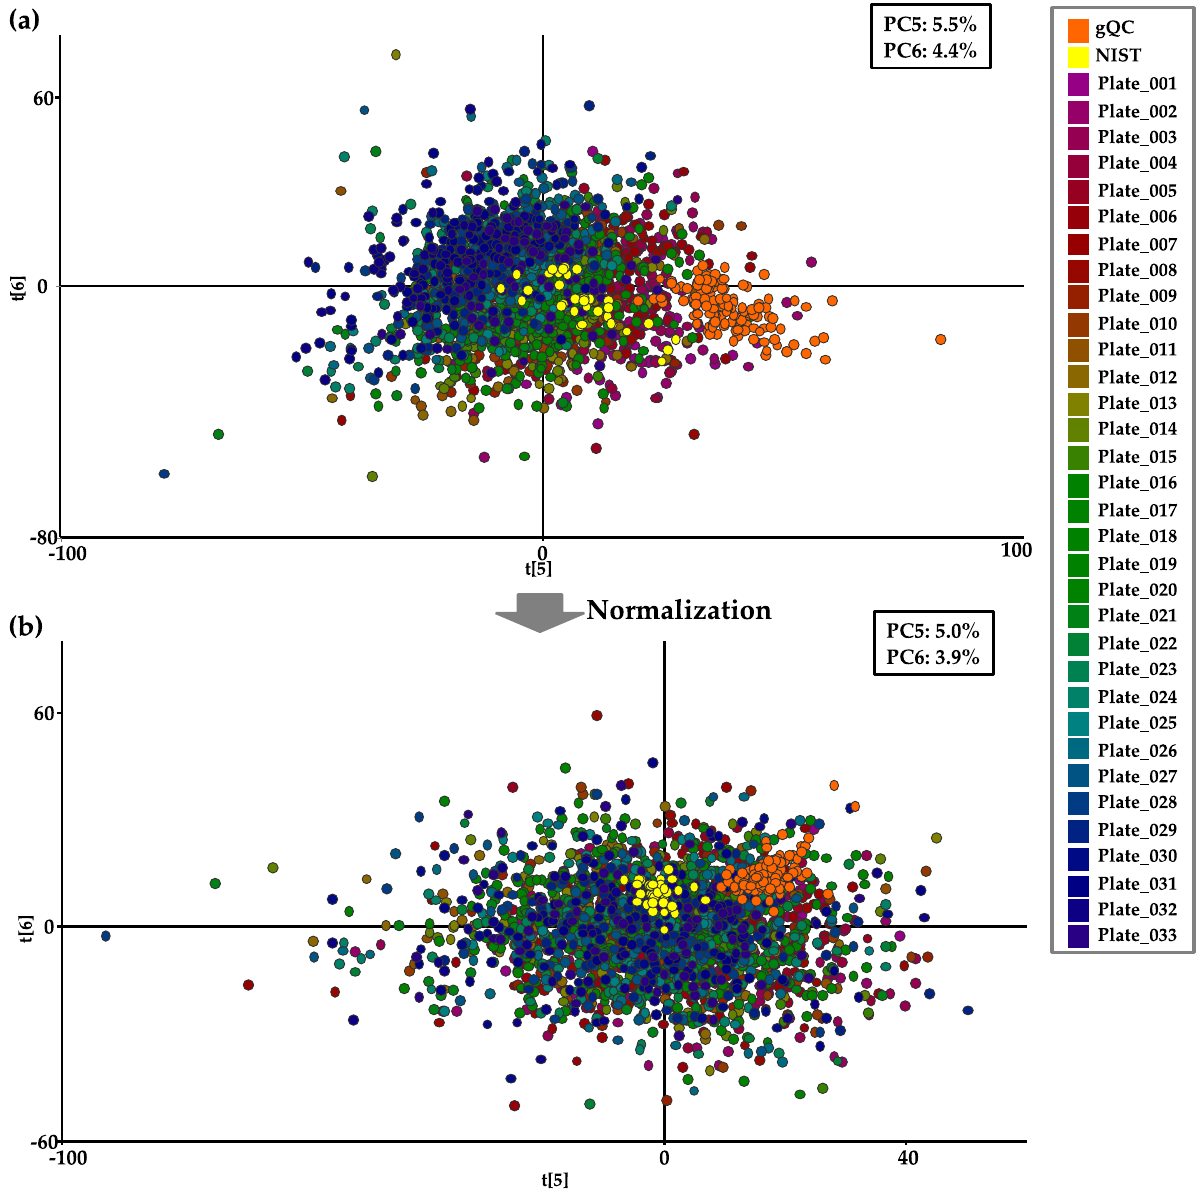
Figure 7. Visualization of the interplate variation in the metabolites in the cohort of 2541 plasma samples with 33 NIST plasma samples and 132 gQC plasma samples detected by Kit-Met 2 on the PCA score plot before ( a ) and after ( b ) normalization by gQC. Samples are represented by dots color-coded for the 33 continuous plates. * The NIST and gQC plasma samples are represented as yellow and black dots,